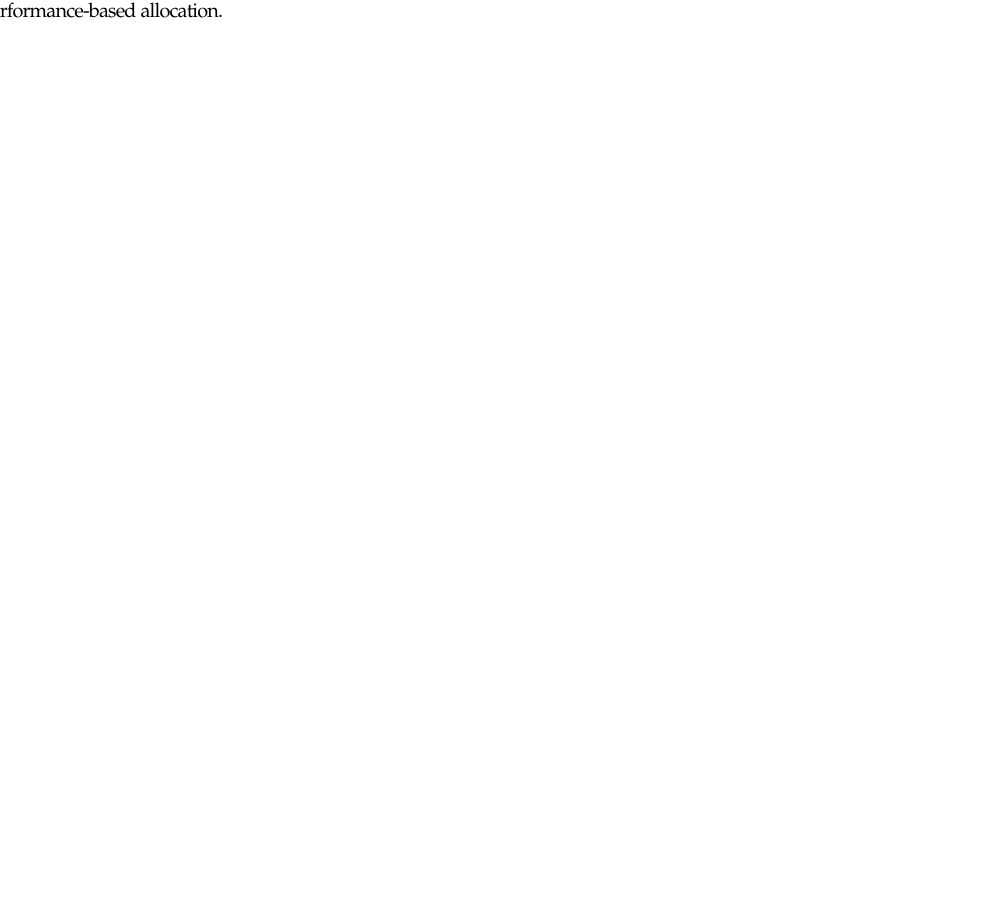
RA = random allocation, PBA =